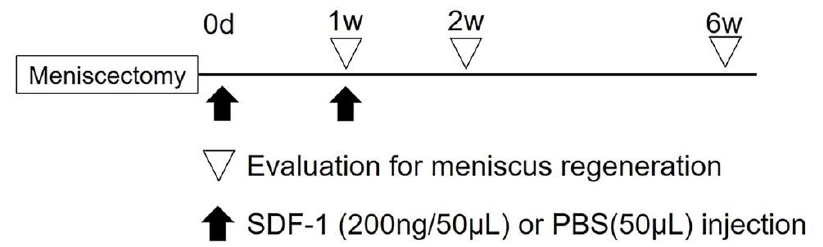
Figure 4. Study protocol. At the time of meniscectomy, 200 ng of SDF-1 with 50 µ L of PBS or 50 µ L of PBS was administrated, and 5 rats from each group were sacrificed via CO 2 inhalation 1 week later. The remaining rats in each group were reinjected with 200 ng / 50 µ L of SDF-1 α (or PBS) into the left knee joint at 1 week after meniscectomy. They were then sacrificed via CO 2 inhalation at 2 and 6 weeks after meniscectomy.